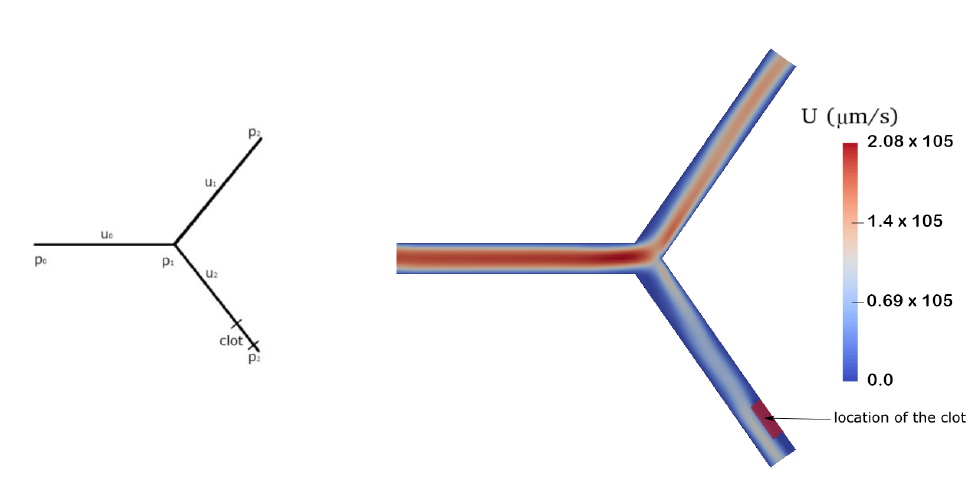
Figure 4. Schematic representation of bifurcating vessels (left) with a clot located in vessel 2, u i , i = 0,1, 2 are the average flow velocities in the corresponding vessels, p 0 is the pressure at the flow inlet and p 2 at the outlet, and p 1 is the pressure at the bifurcation point. Flow velocity in 2D numerical simulations with the Navier–Stokes equations in the same vessels (right image is increased for a better representation of the velocity